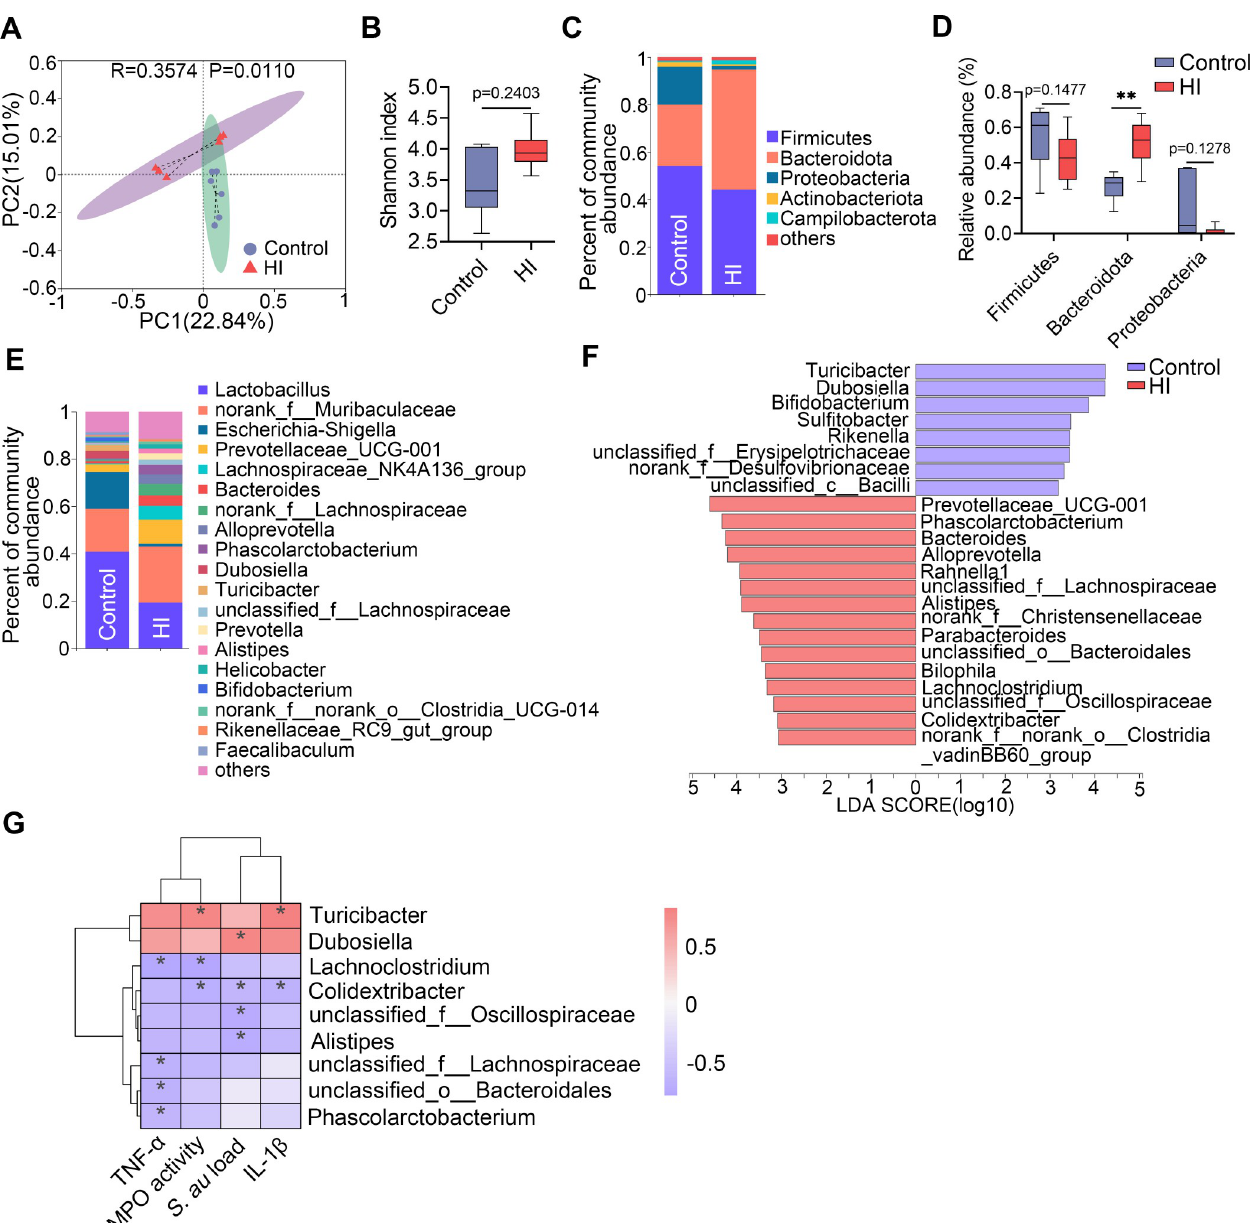
Fig 4. HI diet alters the gut microbiota in mice. Mice were fed a control diet or HI diet for three weeks and the gut microbiota were analyzed by 16S rRNA sequencing. A. PCoA showed different gut microbial structure between the control and HI groups based on unweighted UniFrac distance (R = 0.3574, P = 0.0110, n = 6). B . Shannon index from the indicated groups (n = 6). C . Top five gut microbial compositions at the phylum level from different treatment groups. D . Relative abundances of selected bacterial taxa in the gut microbiota from different groups (n = 6). E . Bacterial composition at the genus level in the indicated groups. F . LEfSe showed different bacterial taxa that were enriched in different groups (log10 LDA score > 3). G . Spearman correlation analysis between selected gut microbial taxa and mammary inflammatory parameters. Red indicates a positive correlation, and green indicates negative correlation. Data are expressed as boxplots and the Mann-Whitney U test was performed for statistical analysis ( B and D ). �� p < 0.01 indicates a significant difference. mice in the HIF + S . au group displayed a lower degree of mammary inflammatory injury than those in the CF + S . au group ( Fig 5F and 5G ). Notably, a lower bacterial burden was also observed in the HIF + S . au group than in the CF + S . au group ( Fig 5H ). Consistently, HIF reduced mammary inflammatory markers, including MPO activity ( Fig 5I ) and TNF- α